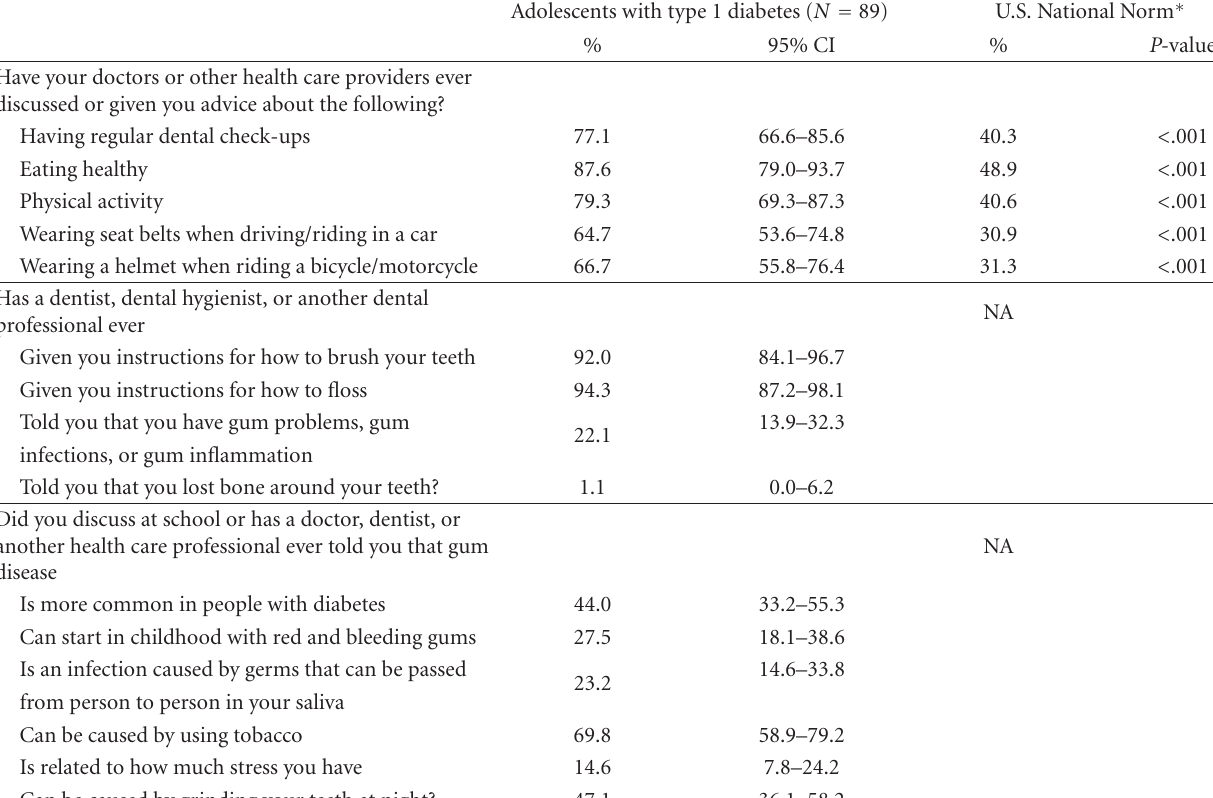
Table 4: Sources of health information and